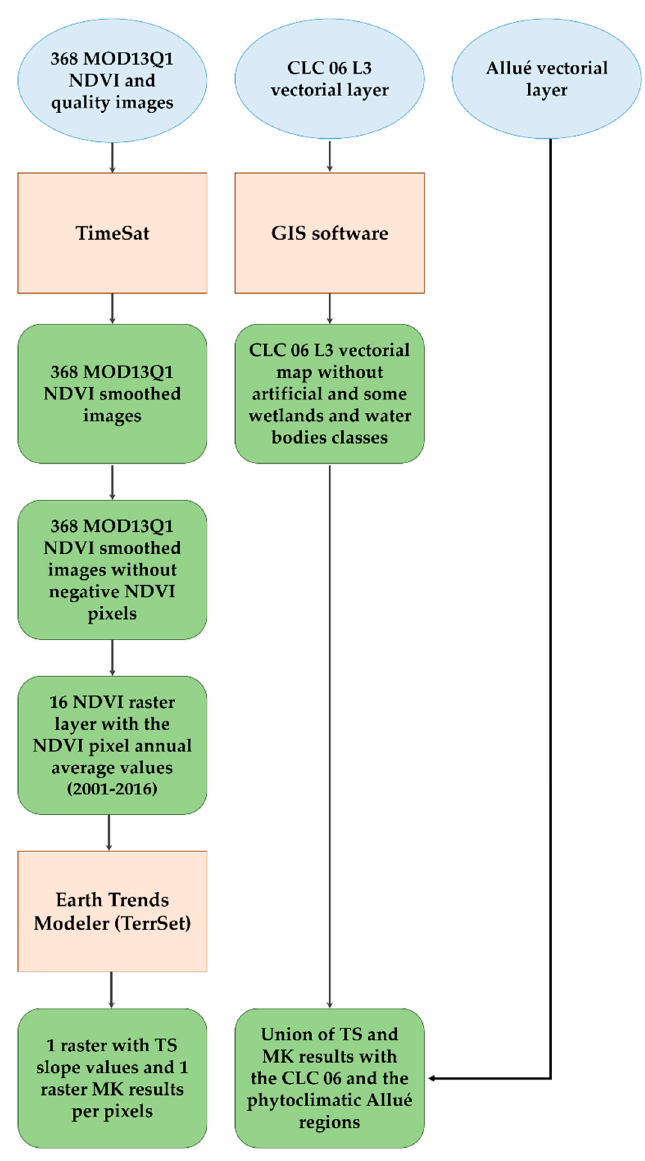
Figure 4. Data processing scheme. TS refers to Theil–Sen slope data and MK refers to the Mann–Kendall test.